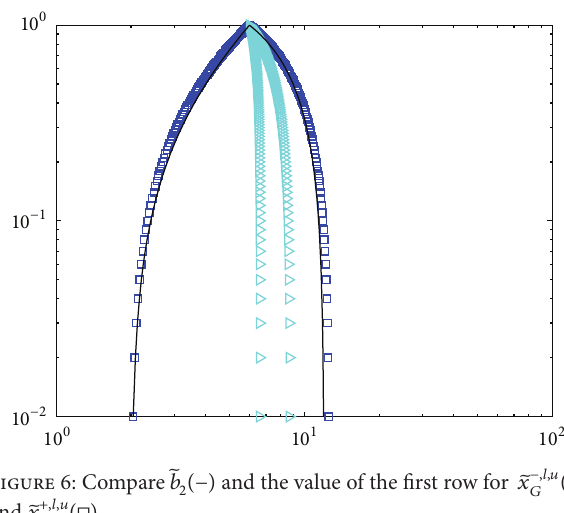
Figure 6: Compare and ̃𝑥 +,𝑙,𝑢 𝐺 (◻)